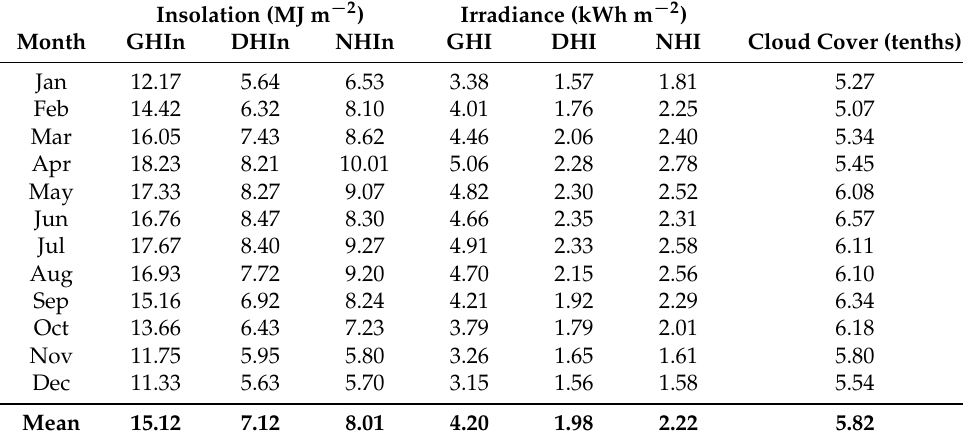
Figure 4. Climatological annual cycle given by the mean monthly daily values for the three compo- nents of solar radiation, GHI, NHI and DHI for the entire period 1981–2016 at Camagüey. Left axis represents insolation quantity (in MJ m − 2 ) and right axis irradiance values (in kWh m − 2 ). Table 1. Monthly mean daily values expressing the climatology of solar irradiance and insolation for the three solar components and cloud cover mean for period of measured data (1981–2016) in Camagüey